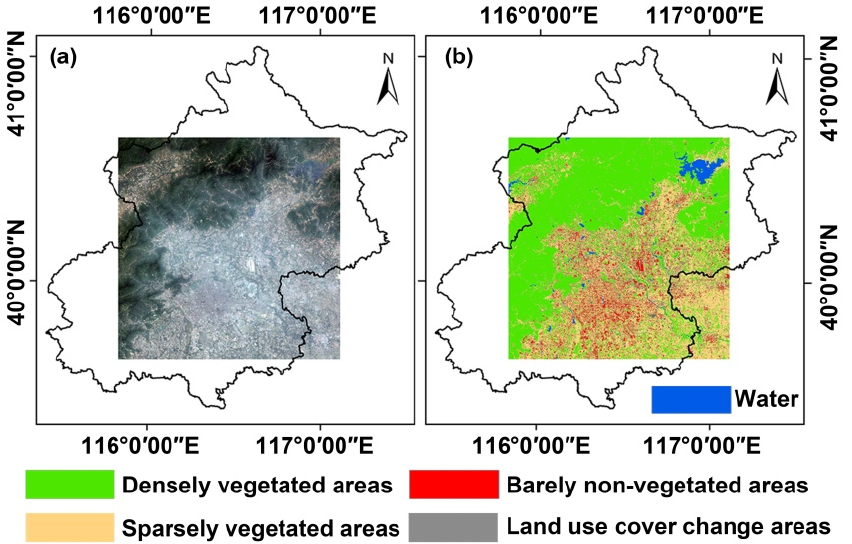
Figure A2. Monthly LSR determination in ( a ) January, ( b ) April, ( b ) July, and ( d ) October over study areas.